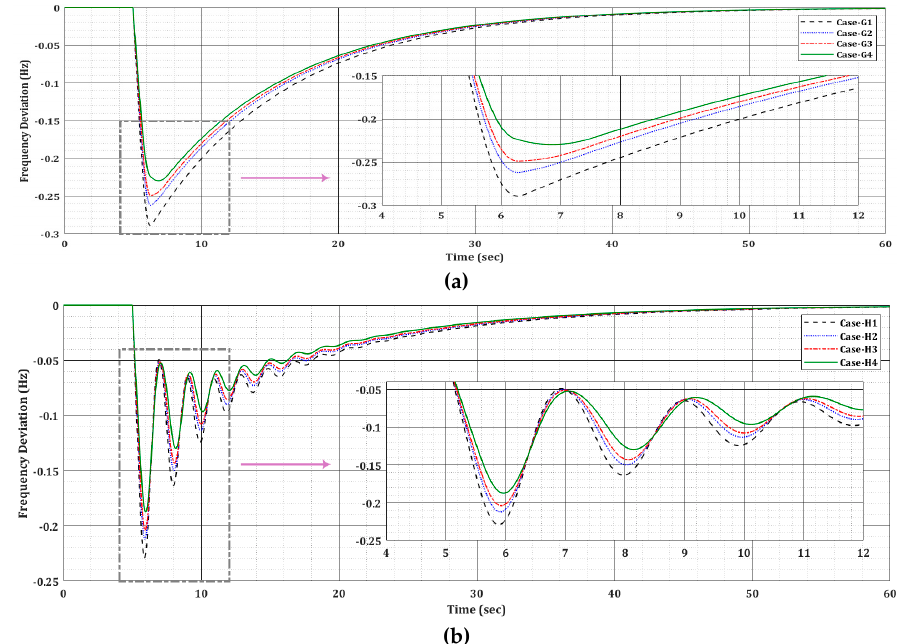
Figure 8. Frequency response under load disturbance when the test system has responsive loads and ESS ( a ) frequency deviation for test cases (G1-G4); ( b ) frequency deviation for test cases (H1-H4).